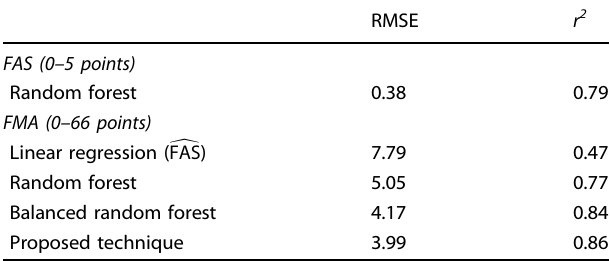
Table 2. Accuracy of the FAS and FMA estimation algorithms investigated in the study.